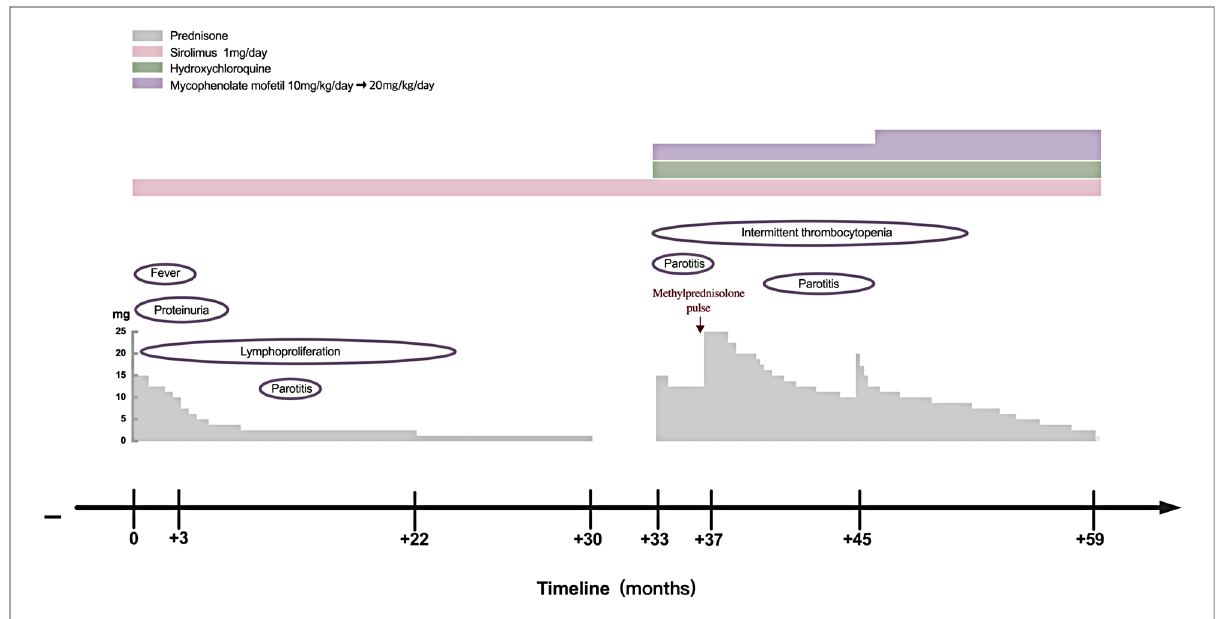
FIGURE 4 Clinical course of the patient with APDS1. APDS1, activated phosphoinositide 3-kinase- δ syndrome